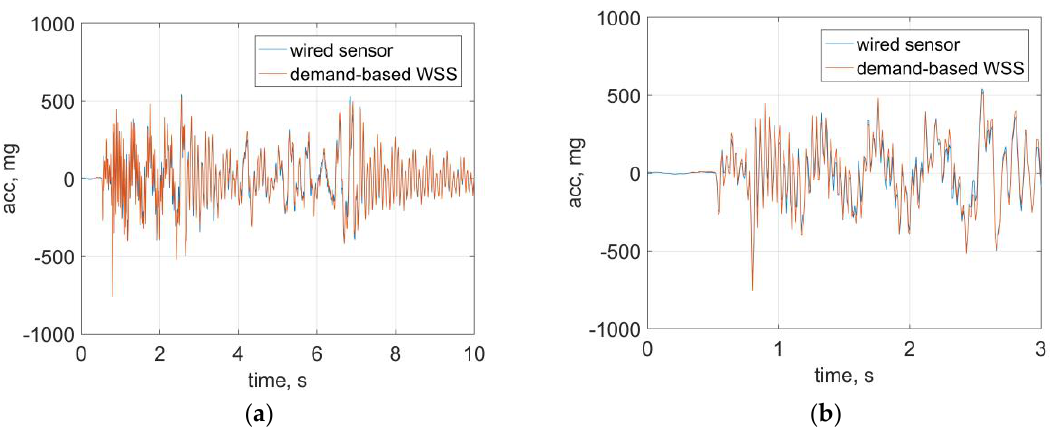
Figure 8. Results of data fusion: ( a ) time history data, ( b ) zoomed view (ADXL362 data).